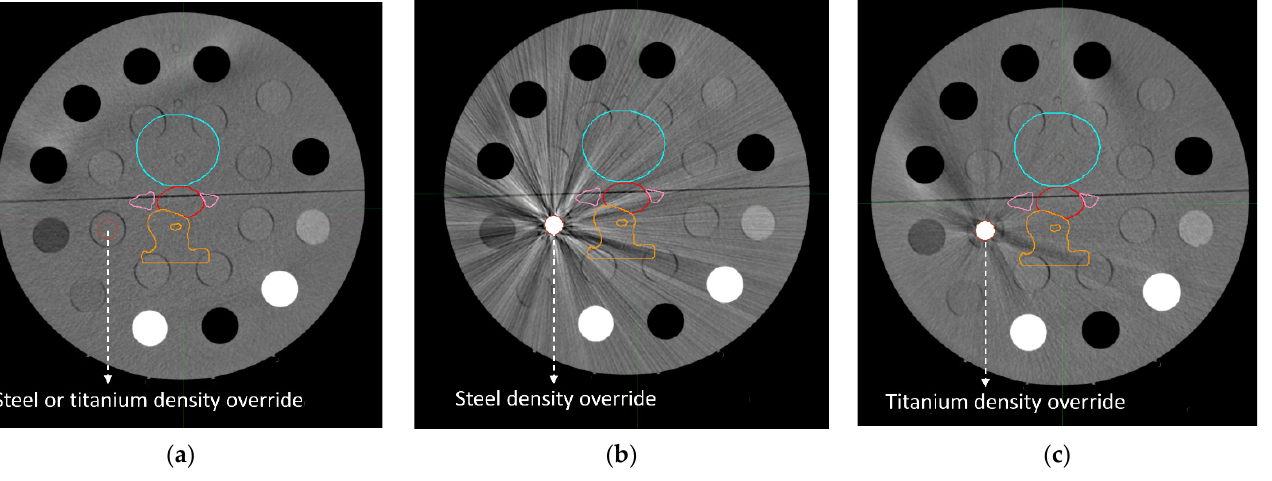
Figure 3. The CT scans (transverse sections) of the Cheese phantom reconstructed with the standard algorithm Qr40 at 120 kVp: ( a ) without metal inserts; ( b ) with the stainless ‐ steel insert; ( c ) with the titanium insert. Structures of the targets (prostate in red and vescicles in pink) and organs at risk (bladder in light blue and rectum in orange) are visible at the center of each phantom. The density override in the brown ROI of figure ( a ) allows two ideal phantoms to be obtained, simulating the presence of the stainless ‐ steel insert and the titanium insert, respectively, but without artifacts. The override of densities was also conducted in the metallic ROIs of the other CT scans ( b , c ).